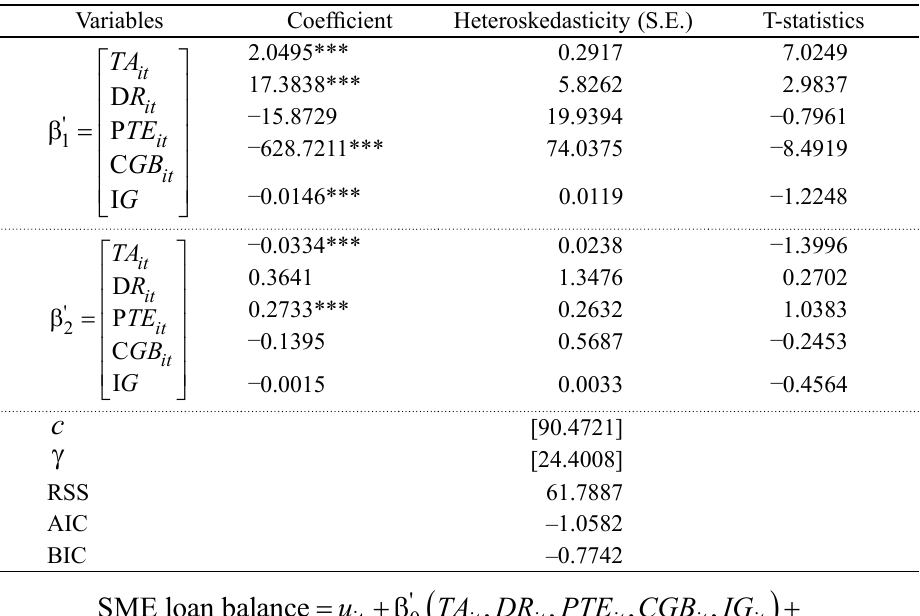
Table 7. Estimation results of the one-threshold PSTR model for medium-sized banks